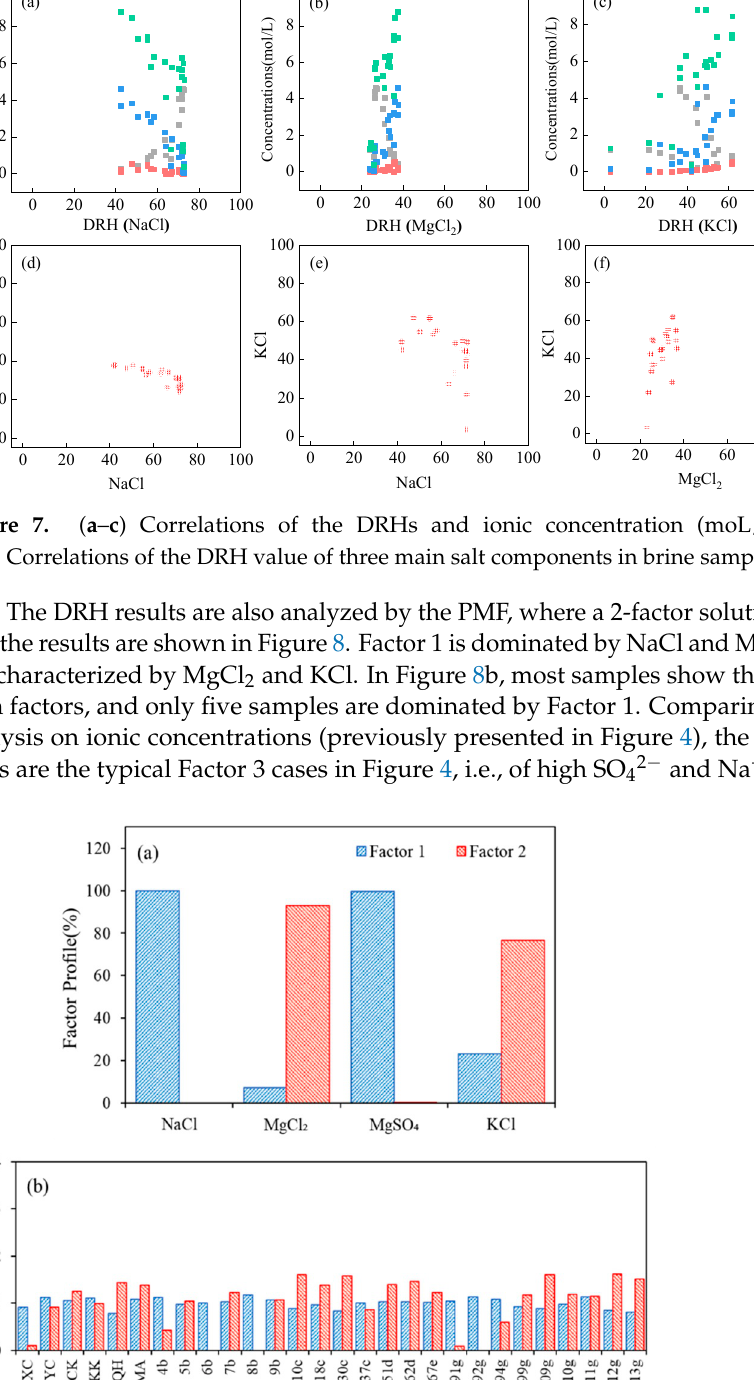
Figure 7. ( a – c ) Correlations of the DRHs and ionic concentration (moL/L) of four ions. ( d – f ) Correlations of the DRH value of three main salt components in brine samples.